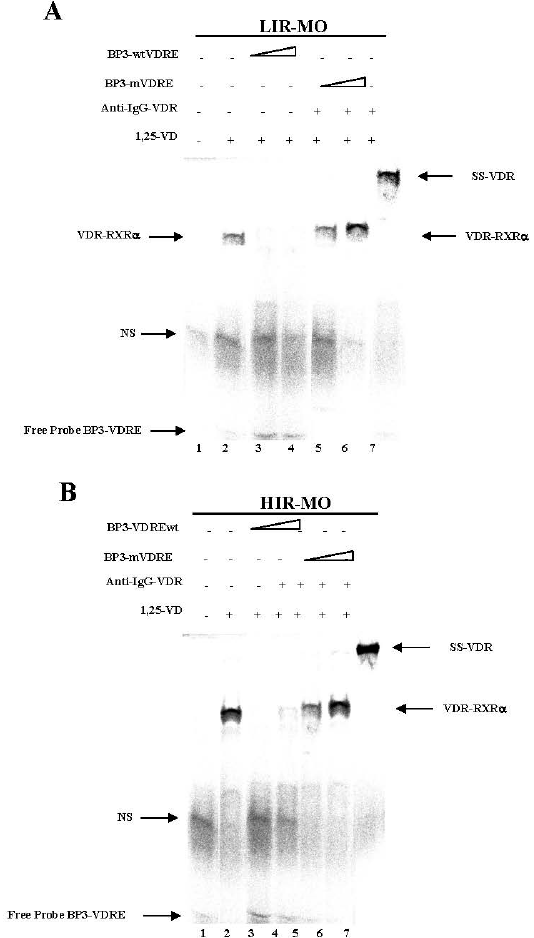
Figure 6. Specific binding activity of VDR to the putative BP3-VDRE sequences by the EMSA non-radioactive method. The biotin 3 ′ end labelled probe BP3-VDRE ( A , B ) was incubated with 5 μ g of nuclear extract isolated from LIR-MO ( A ) and HIR-MO ( B ) both in the presence of 1,25-D (lane 2). For competition experiments, wild-type non-labelled BP3-wtVDRE ( A , B ) (lanes 3, 4, and 5), and mutated BP3-mVDRE ( A ) (lanes 5, 6, and 7). Supershift was performed with specific antisera to VDR ( A , B ) yielding supershifted complexes (lane 7). Lane 1, no nuclear extract.